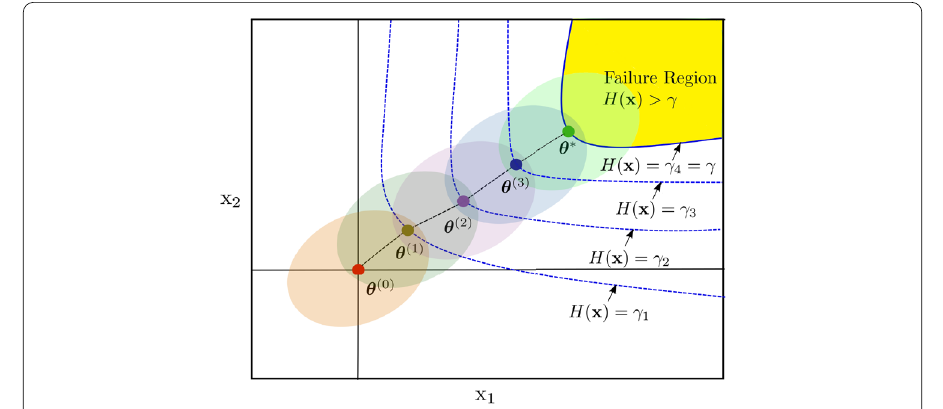
Figure 1 Multi-level (mean-shift) ISMC